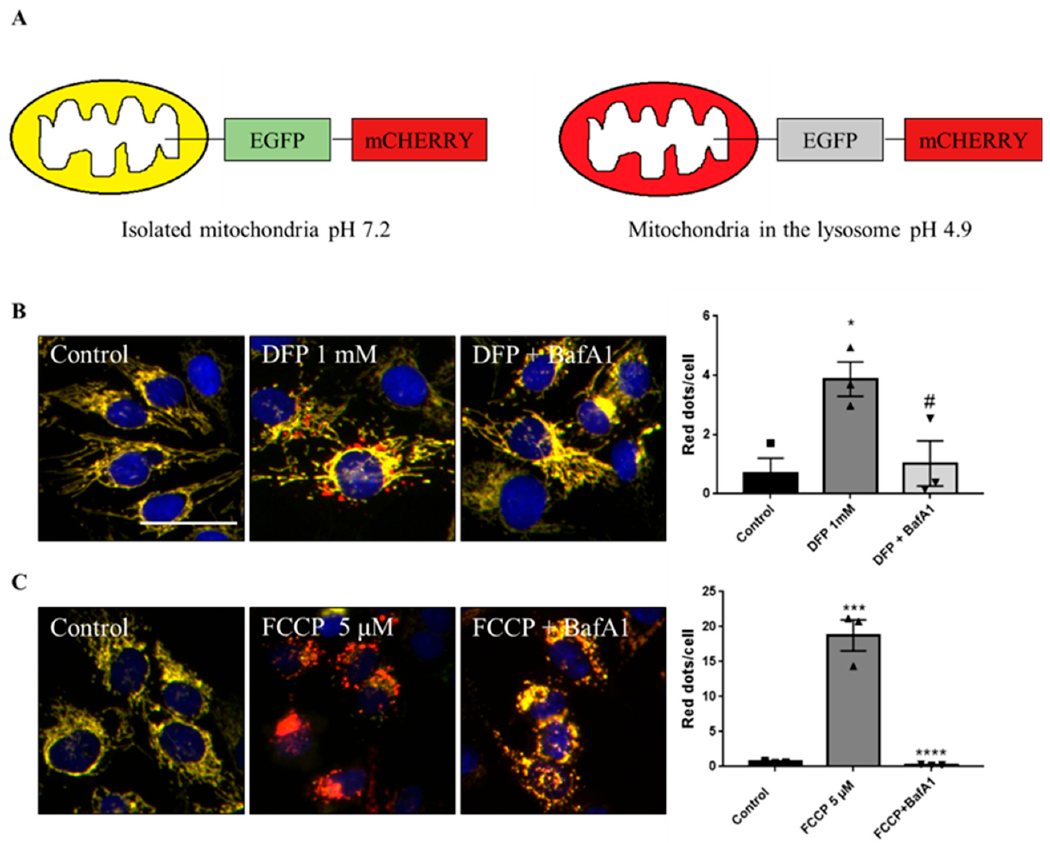
Figure 1. Description of the iMLS reporter and assay setup. ( A ) Mitophagy reporter description. ( B ) Representation and quantification of mitophagy modulations in U2OS-iMLS cells treated with DFP for 24 h. BafA1 was added for the last 2 h. ( C ) Representation and quantification of mitophagy modulations in U2OS-iMLS-PRKN cells treated with FCCP for 24 h. BafA1 was added for the last 2 h. Data represent the mean ± SEM of three experiments (significance was determined by one-way ANOVA followed by Dunnett’s multiple comparisons test where * p < 0.05 and *** p < 0.001 compared with control and # p < 0.05 and **** p < 0.0001 compared with DFP or FCCP, respectively). Scale bar = 50 µ